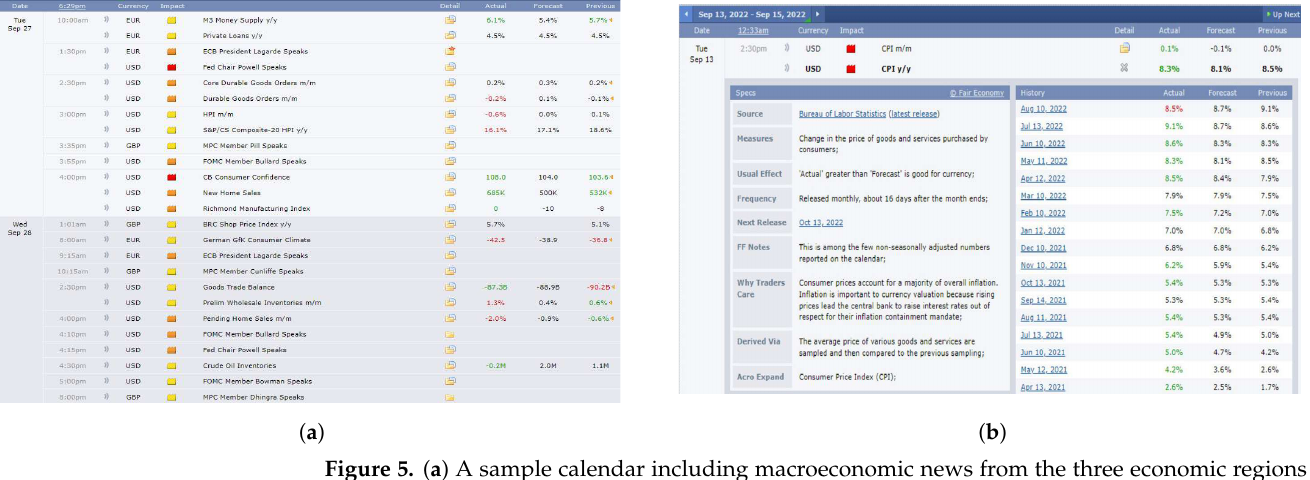
Figure 5. ( a ) A sample calendar including macroeconomic news from the three economic regions under consideration for 27–28 September 2022; ( b ) data collection process for identifying the US Consumer Price Index macroeconomic news in September